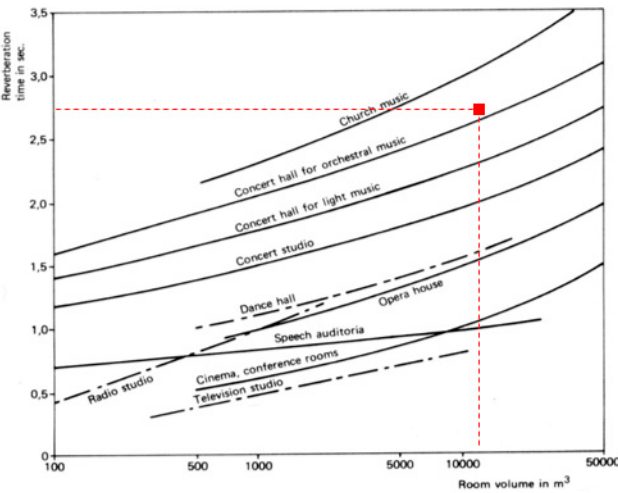
Figure 15. Reverberation Time of S. Dominic of Foligno.